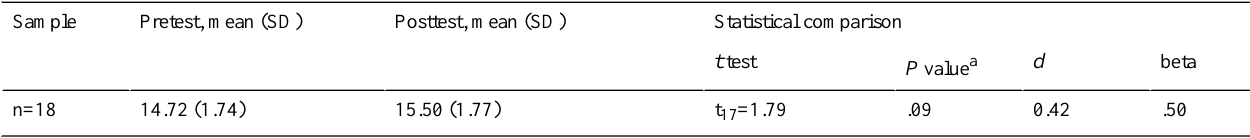
Table 1. Comparison of pretest and posttest knowledge test results (total score range, 0-20).